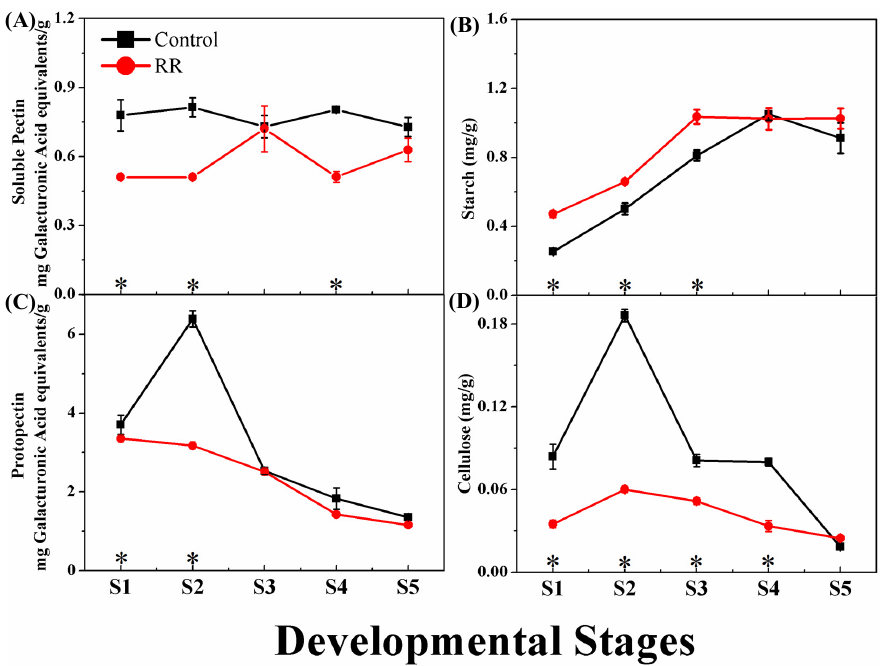
Figure 3. Effects of RR treatment on the content change of starch, pectin, and cellulose of grape berry. ( A ) Soluble pectin; ( B ) starch; ( C ) protopectin; ( D ) cellulose. * indicates significant differences ( p < 0.05, n = 3).